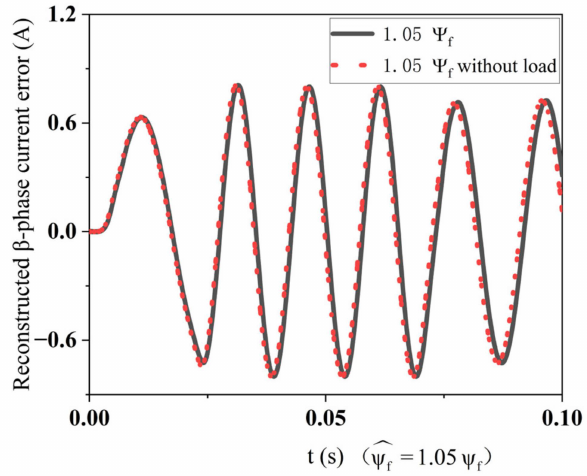
Figure 14. Mismatched β -axis current